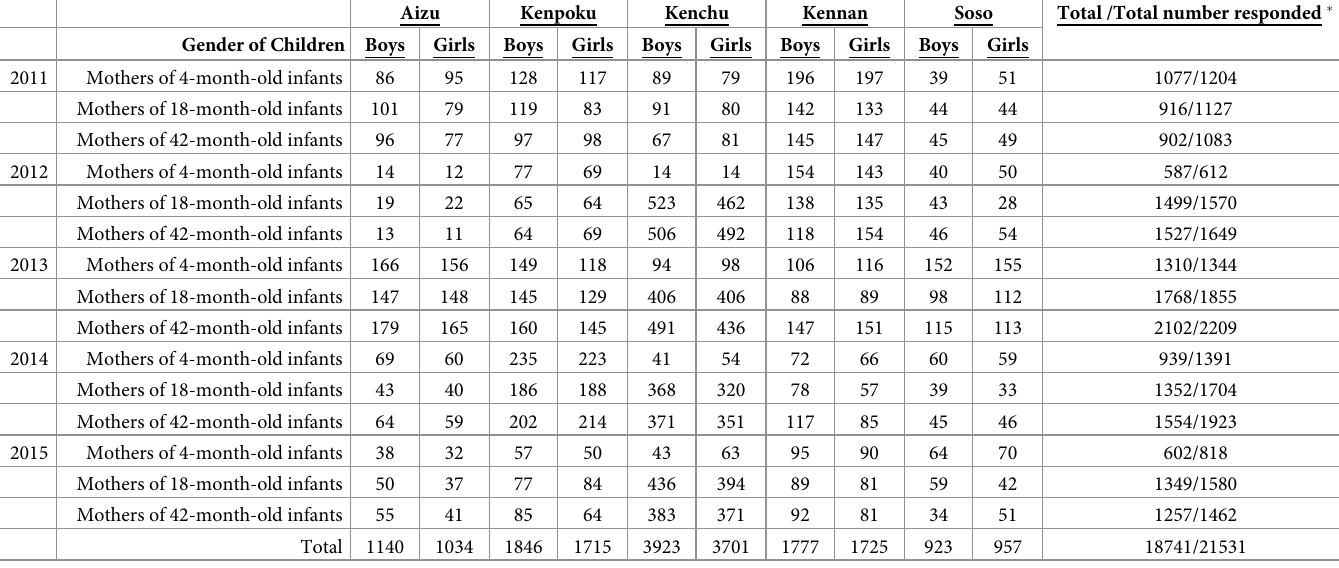
Table 3. Number of cases used for statistical